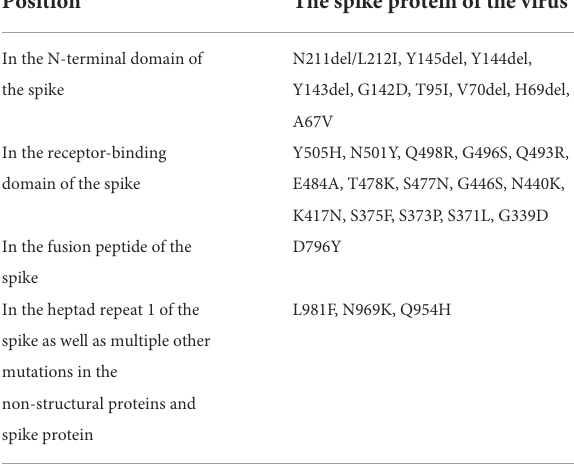
TABLE 2 Omicron showed 30 amino acid mutations in S-protein. Position The spike protein of the